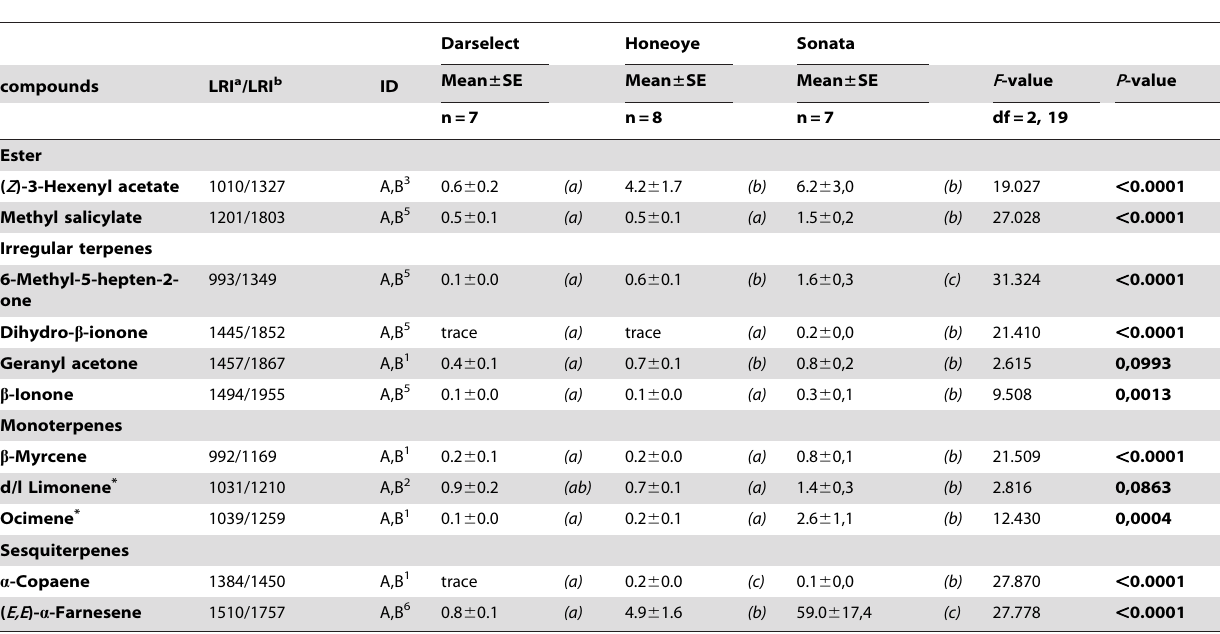
Table 2. Identified flower volatile compounds of three strawberry varieties (ng g 2 1 flowers). Ester, irregular terpenes and sesquiterpenes.